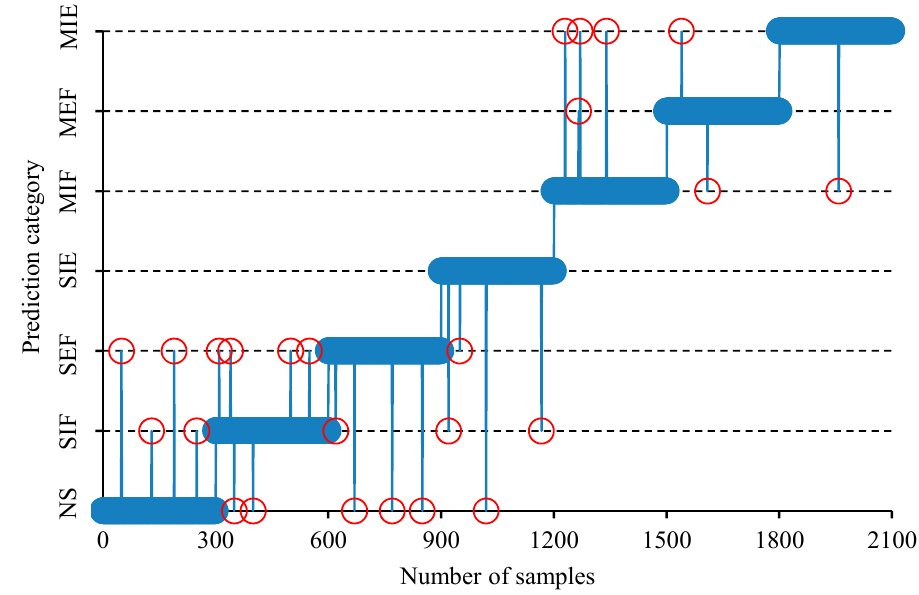
Figure 11. The detailed analysis of diagnostic result.